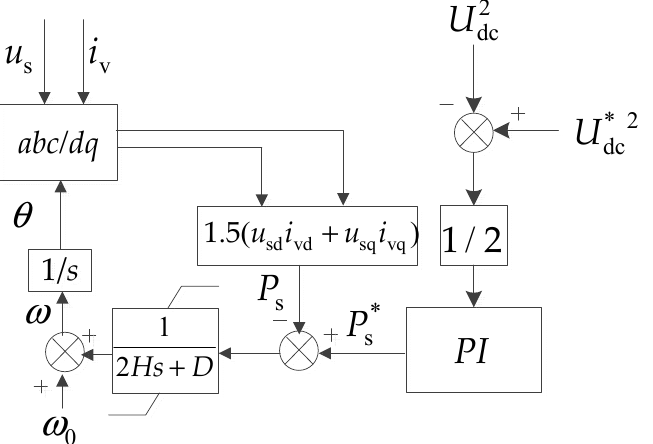
Figure 13. Power synchronization loop diagram of the PV-type grid-forming nonsynchronous- machine source.